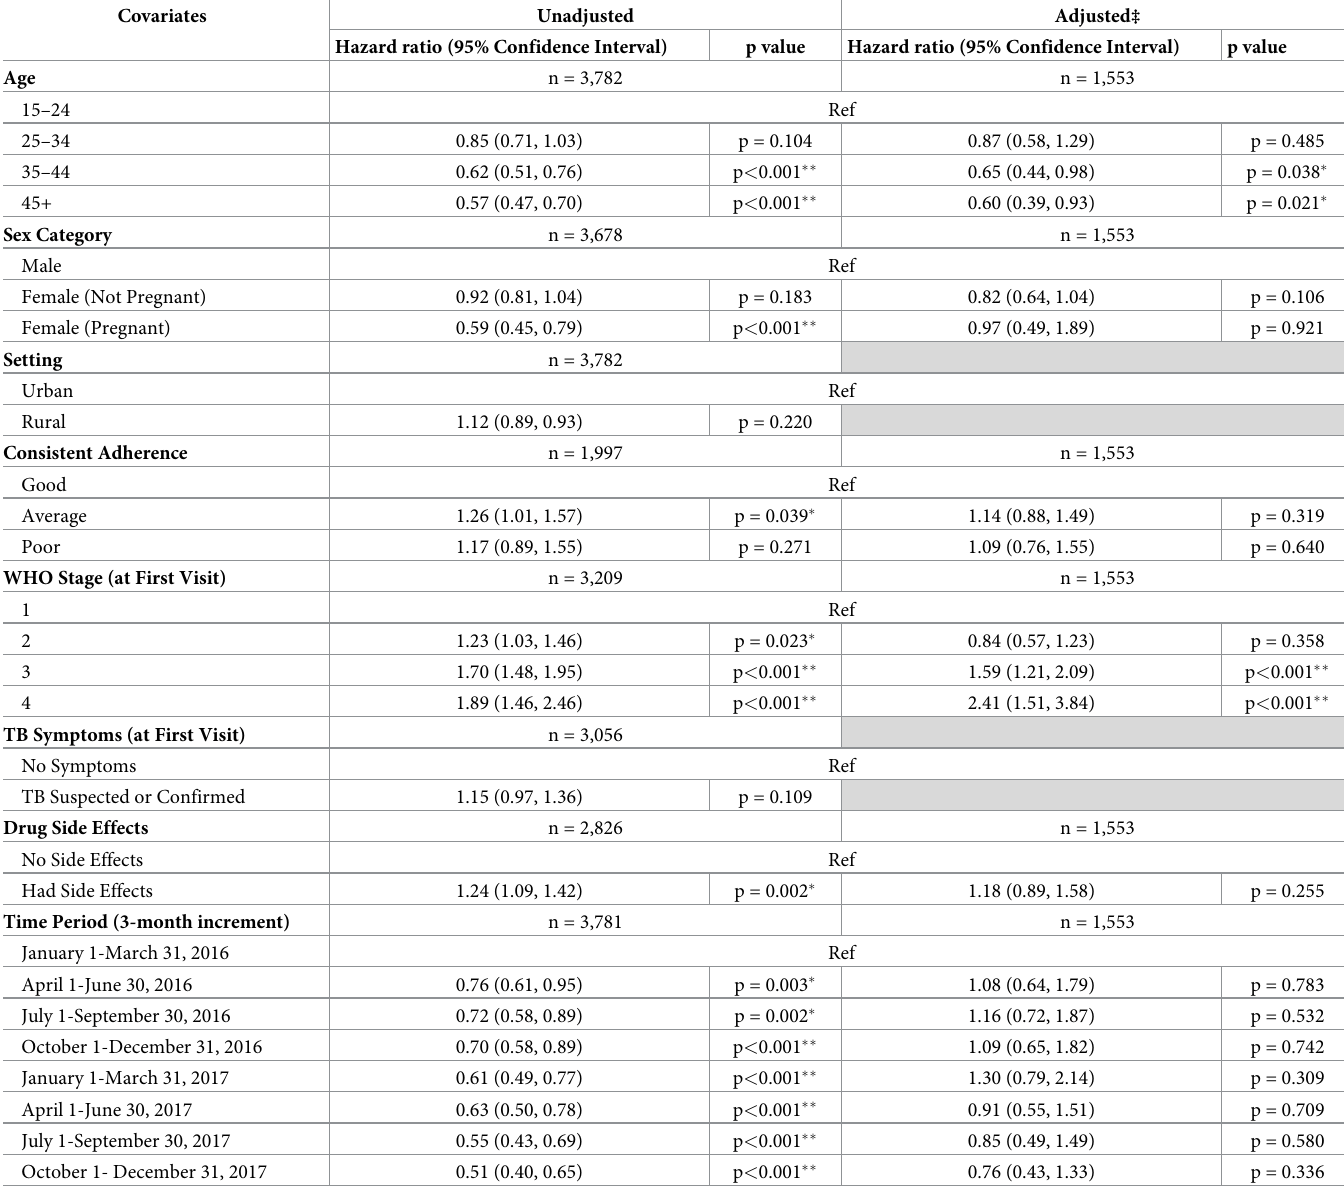
Table 2. Estimates of factors associated with loss-to-follow-up among adolescents and adults in care and treatment.